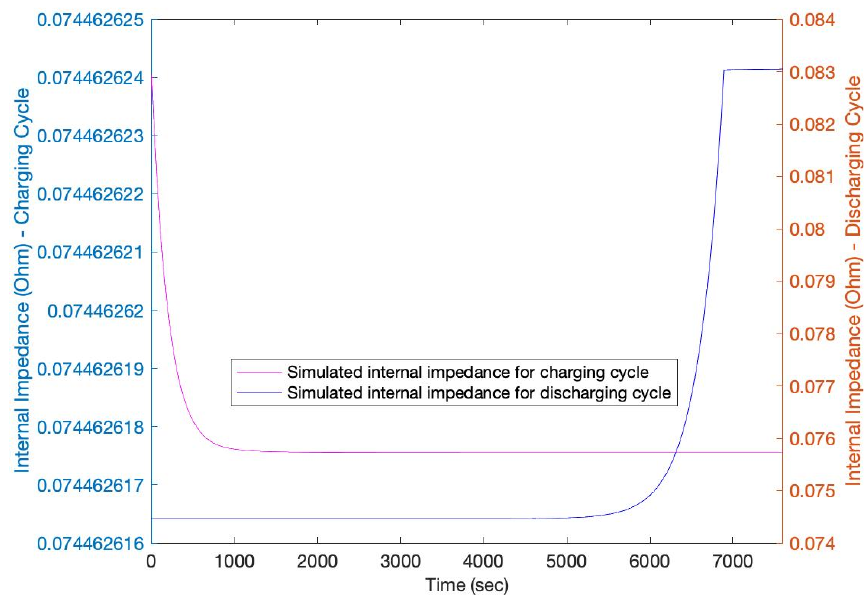
Figure 6. The change in the simulated internal battery impedance over time for the charging/discharging cycles.